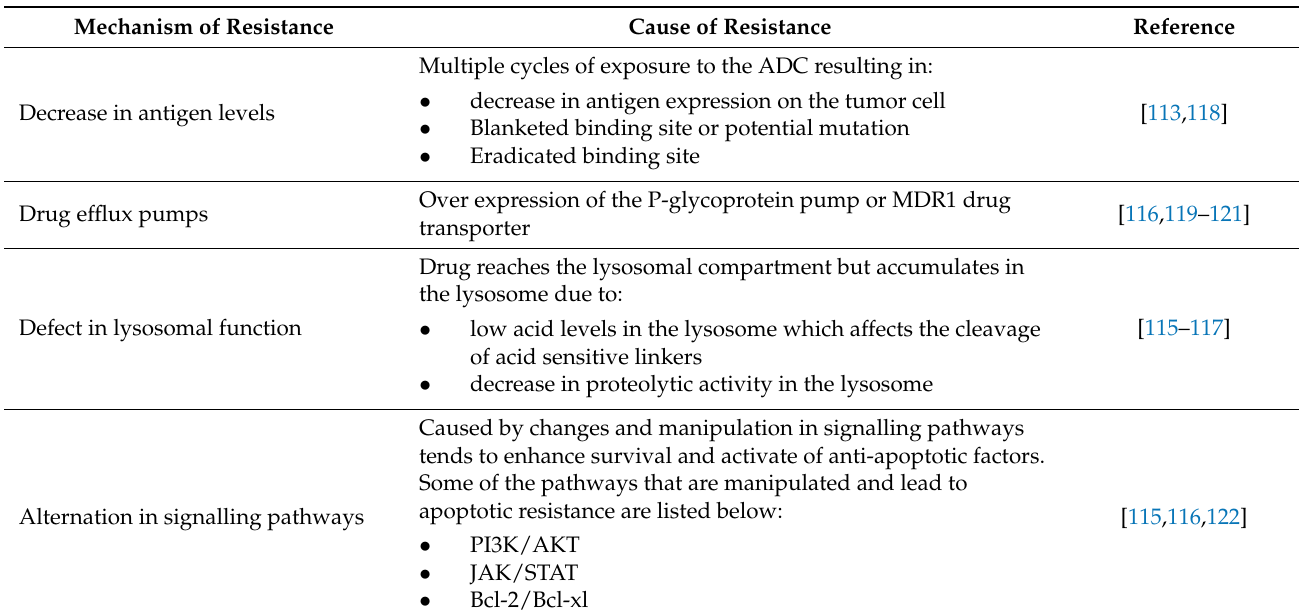
Table 3. Proposed mechanisms of drug